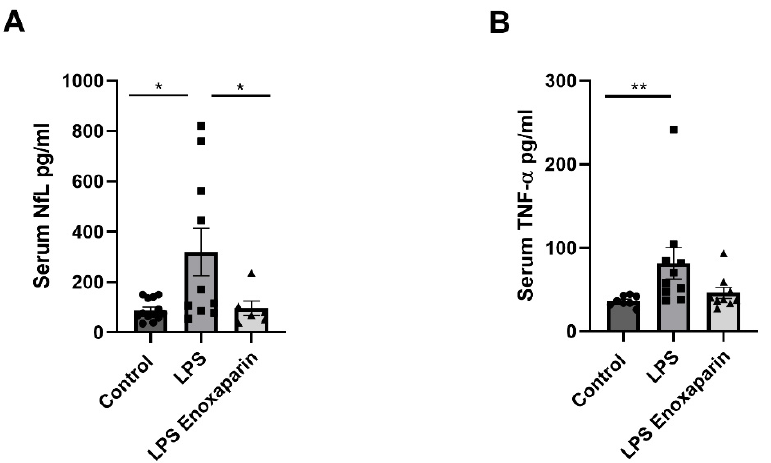
Figure 5. Serum NfL and TNF- α protein levels: Serum NfL ( A ) and TNF- α ( B ) levels were significantly higher in the LPS mice one week following injection compared to controls. Treatment with enoxaparin prevented the serum NfL and TNF- α elevation (NfL: control = 13, LPS = 10, LPS enoxaparin = 6. TNF- α : control = 8, LPS = 10, LPS enoxaparin = 9). NfL—neurofilament light chain; TNF- α —tumor necrosis factor α ; LPS—lipopolysaccharide. * p < 0.05, ** p < 0.01. Circles—control group; squares—LPS group; triangles—enoxaparin-treated LPS group.